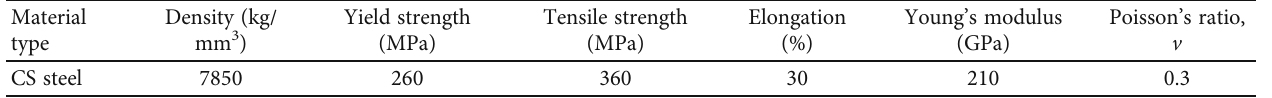
Figure 3: FE discretization of the structure. Table 2: Mechanical property of conventional structural (CS) steel.